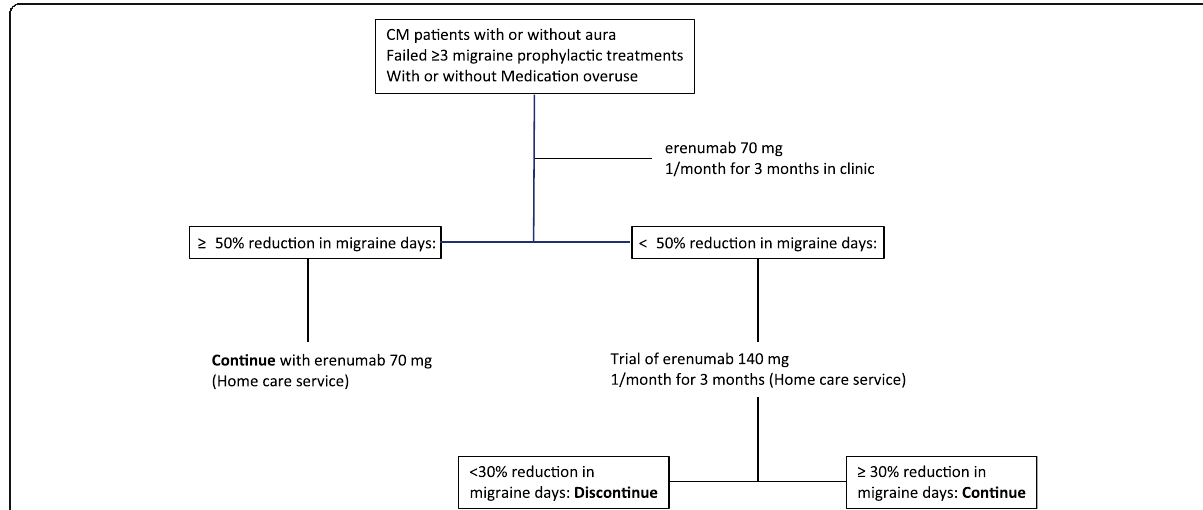
Fig. 1 Audit design: Chronic migraine patients who failed at least 3 preventive treatments, with or without medication overused, were offered monthly subcutaneous injections of erenumab at 70 mg for 3 months. At the three-month time point, patients who achieved at least a 50% reduction in migraine days, were offered the option to continue their treatment with monthly injections of erenumab at 70 mg. Patients who achieved less than 50% reduction in their migraine days, were offered the option to receive monthly injections of erenumab at 140 mg for the next three consecutive months. Any patient who achieved less than 30% reduction in their migraine days at the six-month time point discontinued the erenumab treatment, while patients who achieved at least 30% reduction in their migraine days continue the erenumab treatment at 140